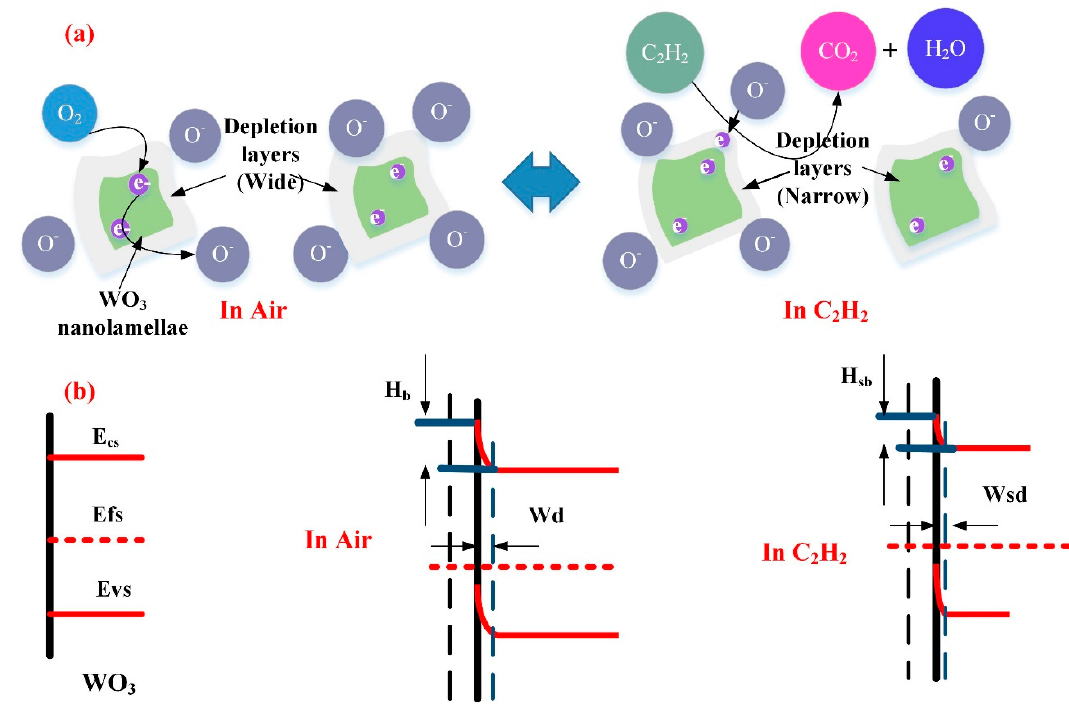
Figure 15. ( a ) Representative physical models for C 2 H 2 gas sensing mechanism of WG0; and, ( b ) Energy band models for C 2 H 2 gas sensing mechanisms of WG0.